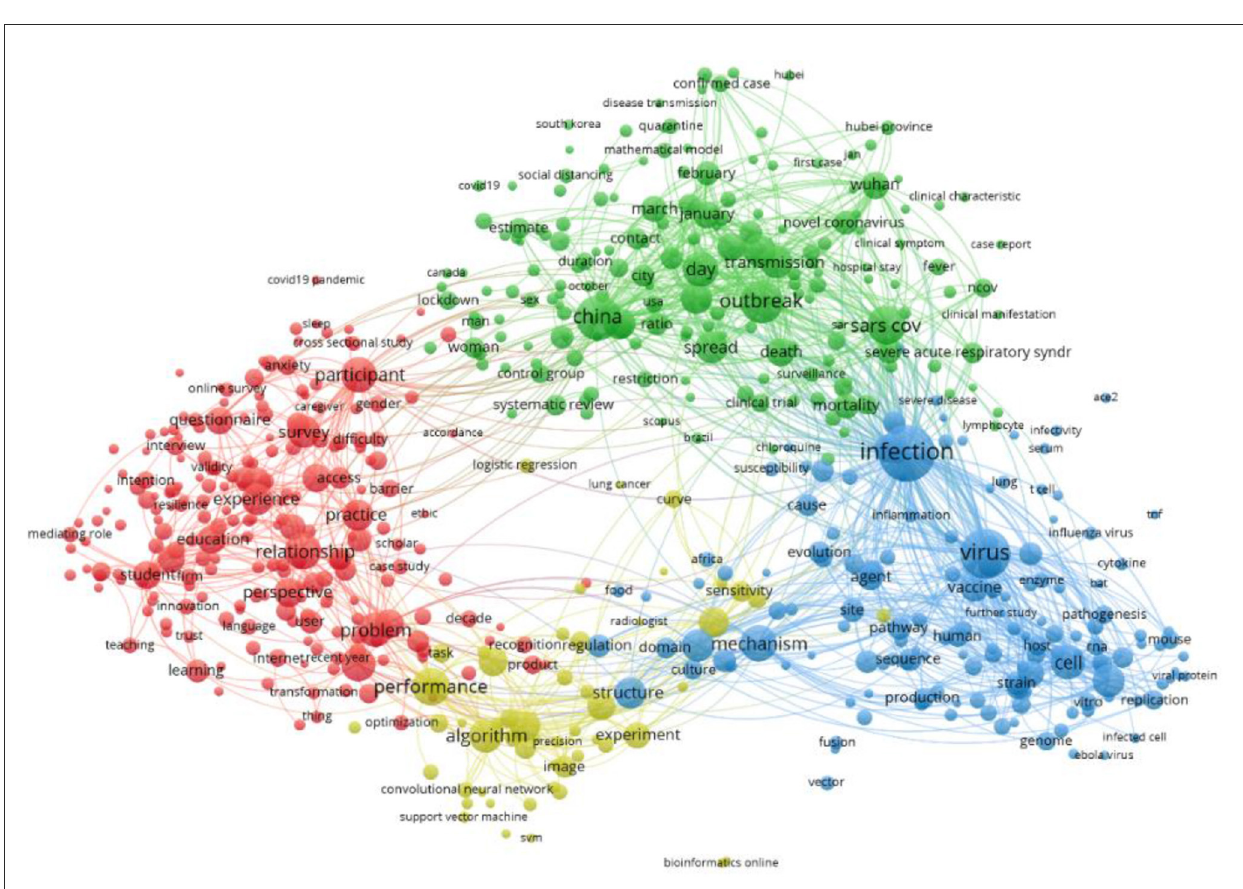
FIGURE2 Network visualization map based on Abstract and